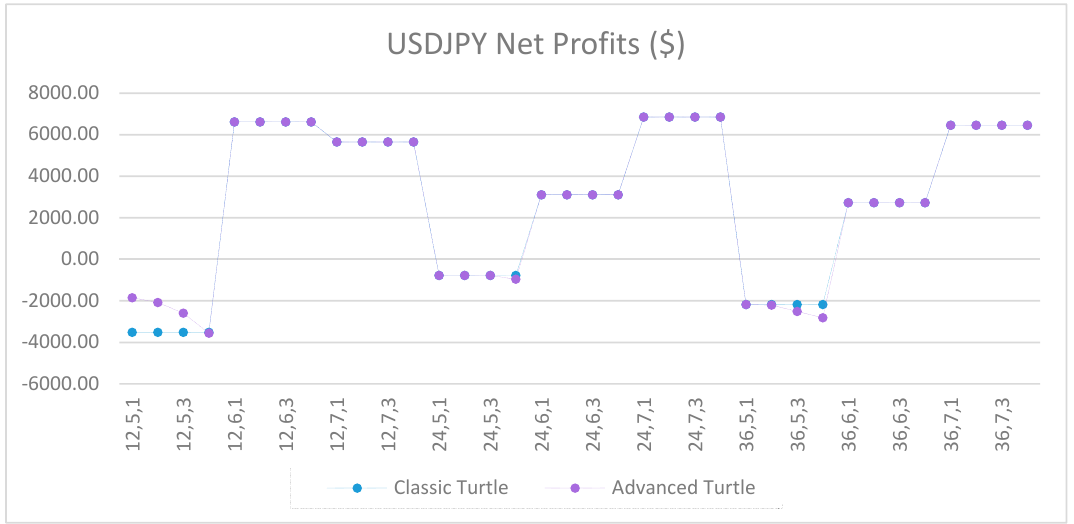
Figure A57. Net profits of USDJPY between the classic and the advanced Turtle systems for every combination of N, X, Y for the slow parameters (80, 160), where X ≥ 5.